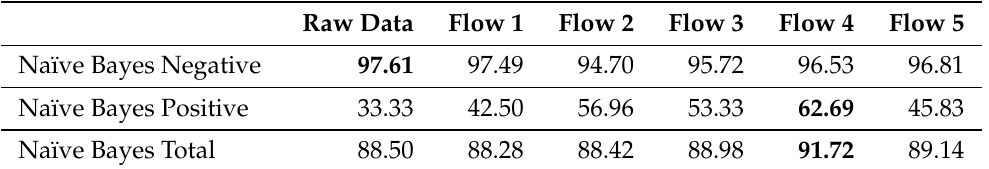
Table 6. Accuracy of the naïve Bayes classifier when testing, separately, with the positive and negative tweets included in the gold